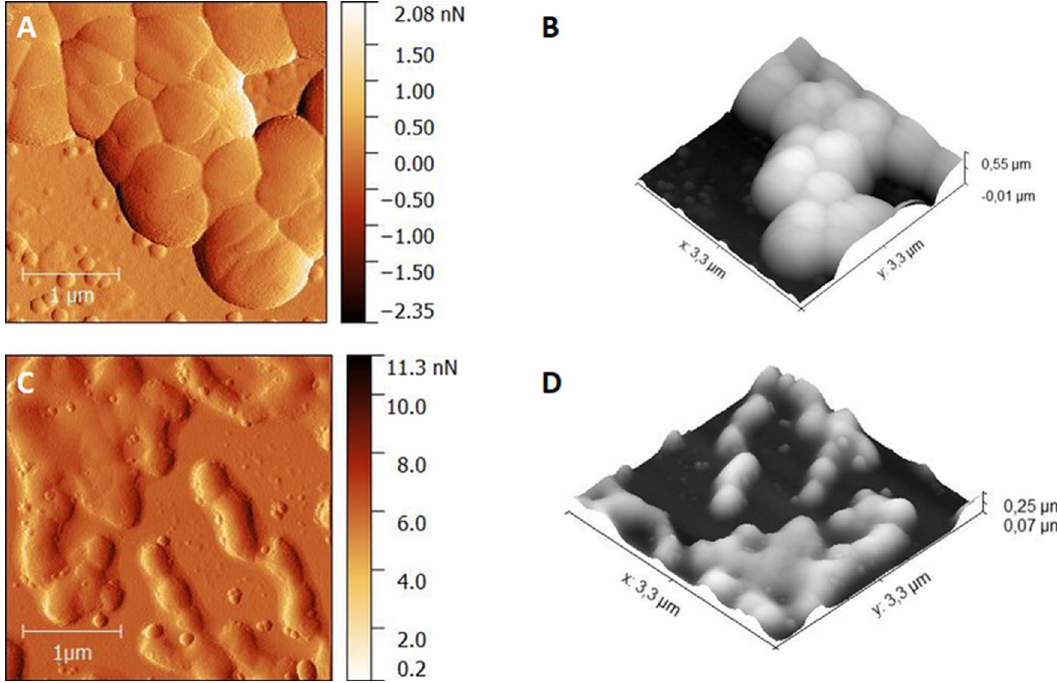
Figure 5. AFM 2D topografy (left panel) ant the corresponding 3D reconstructions (right panel) images of E. feacalis cells before therapy ( A , B , scan area: 3.3 µm × 3.3 µm) and after treatment by TPP-NPs with irradiated